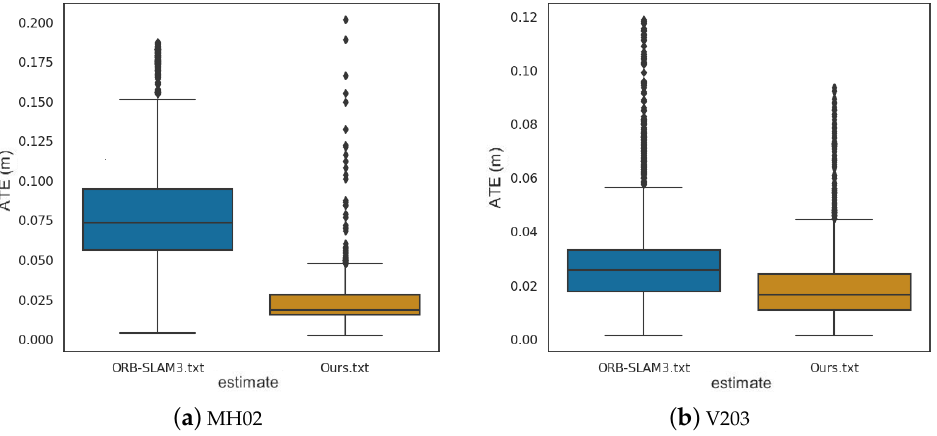
Figure 7. Comparison of ATE (box plot). ( a , b ) are the comparison of ATE between the proposed algorithm and ORB-SLAM3 in MH02 sequence and V203 sequence, respectively, by box plot. The results of ORB-SLAM3 are shown in blue and ours are shown in